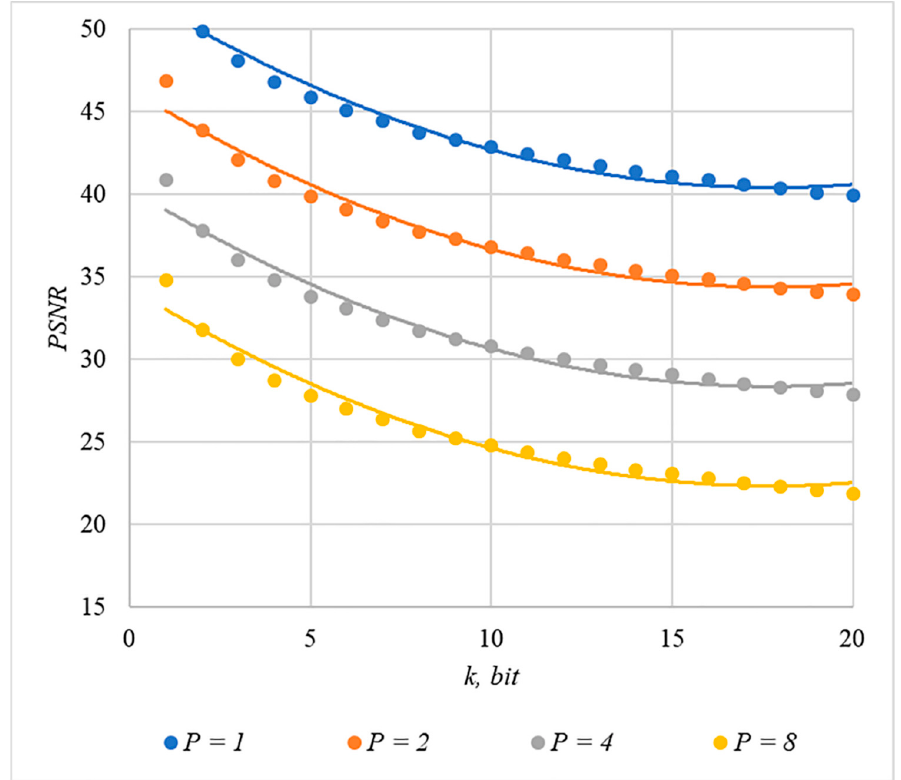
P , rule for generating chip codes № 2. Figure 12. PSNR ( k ) dependencies for different values of